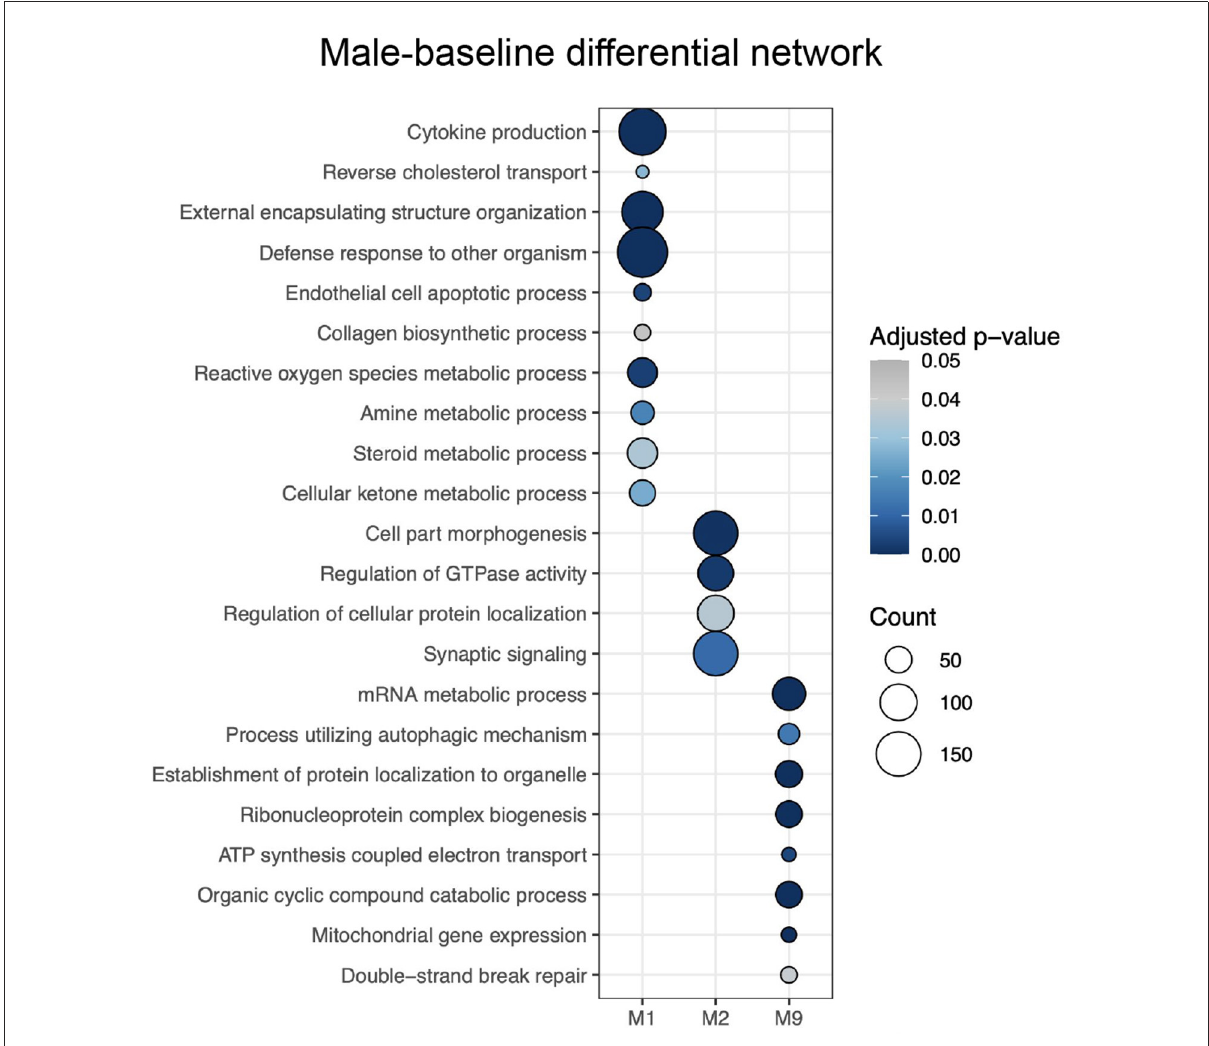
FIGURE4 Enrichment of modules from the male-baseline differential network for GO terms selected by REVIGO. The intensity of the color of the circle indicates the over-representation adjusted p -value, and the size represents the number of genes corresponding to the GO term.